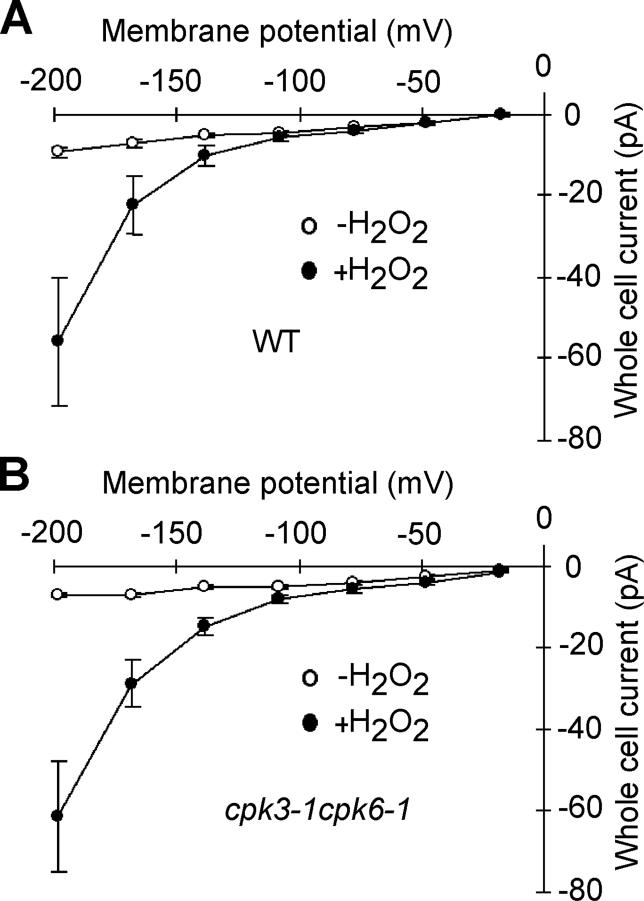
Hydrogen Peroxide Activates ICa Channels Both in Wild-type and cpk3cpk6 Double Mutant Guard Cells(A and B) Exogenous H2O2 (5 mM) activated ICa channels in (A) wild-type (WT) (n = 9) and (B) cpk3-1cpk6–1 double mutant guard cells (n = 12). Error bars represent SEM.